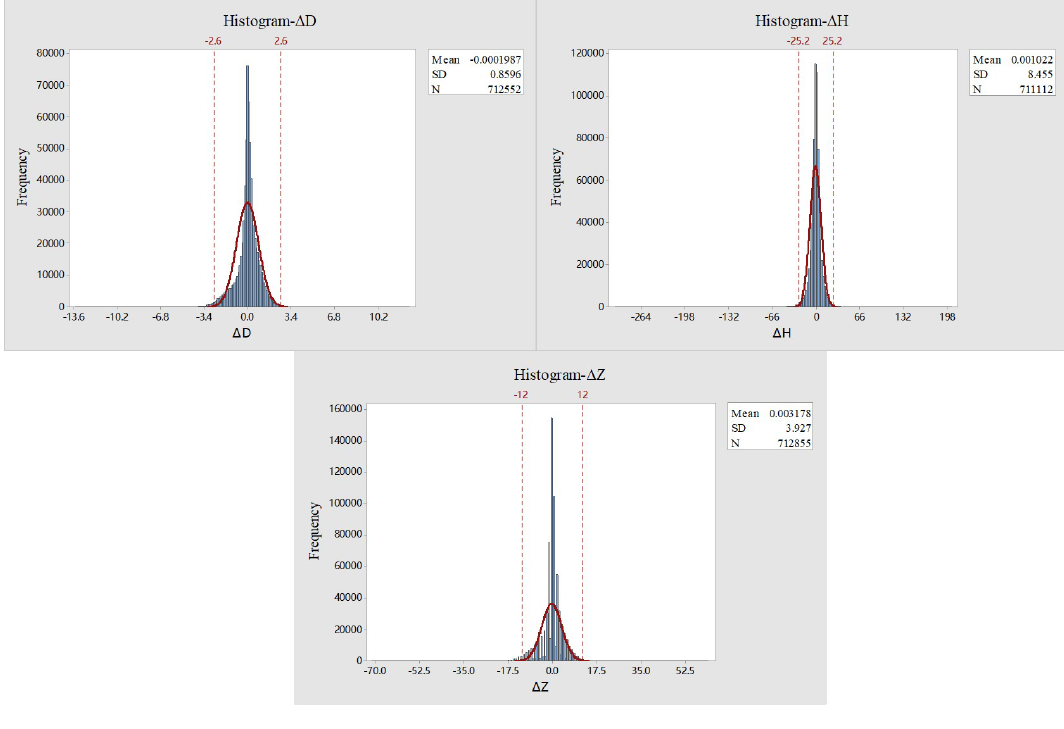
Figure 8. The histogram of the FTD of between 1933 and 2019.